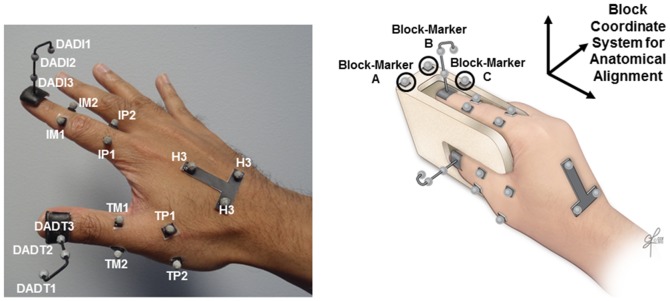
Experimental set-up.LEFT: Markers utilized for motion tracking and computing digit kinematics [13] RIGHT: Calibration using a digit alignment device [14].